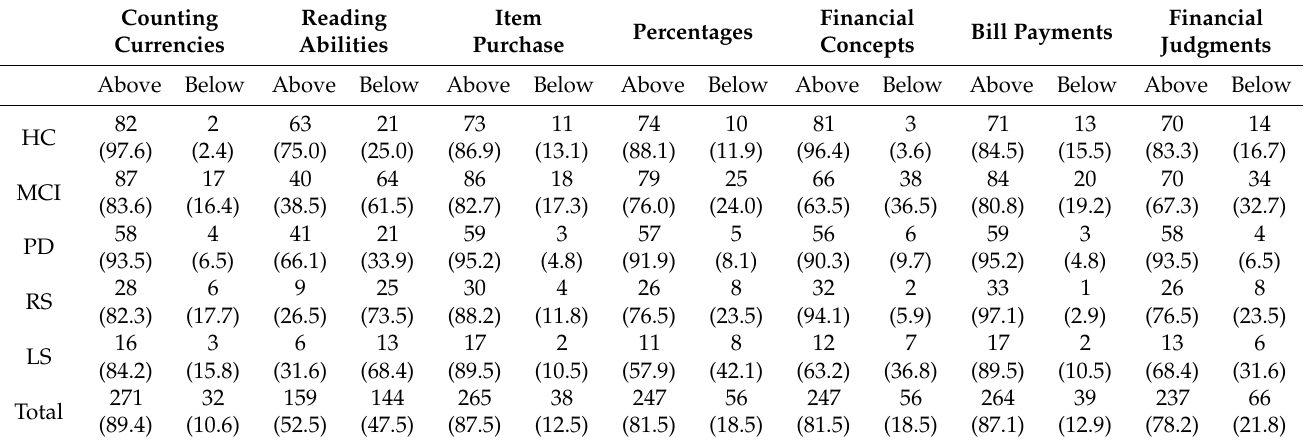
Table 4. Number (%) of participants above/below the cut-off in the seven NADL-F short subtests for each